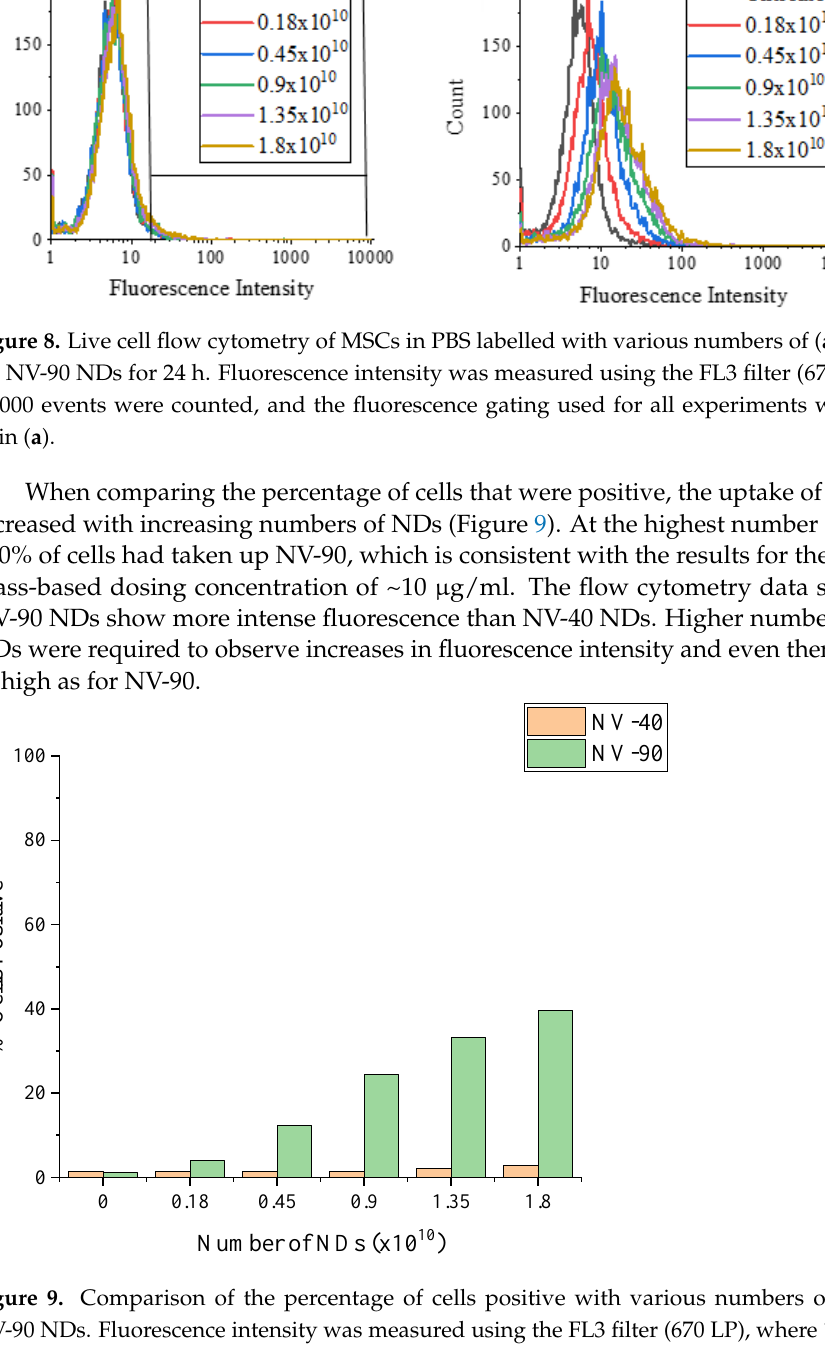
Figure 7. Comparison of the percentage of cells positive with various concentrations of NV-40 and NV-90 NDs. Fluorescence intensity was measured using the FL3 filter (670 LP), where 10,000 events were counted.